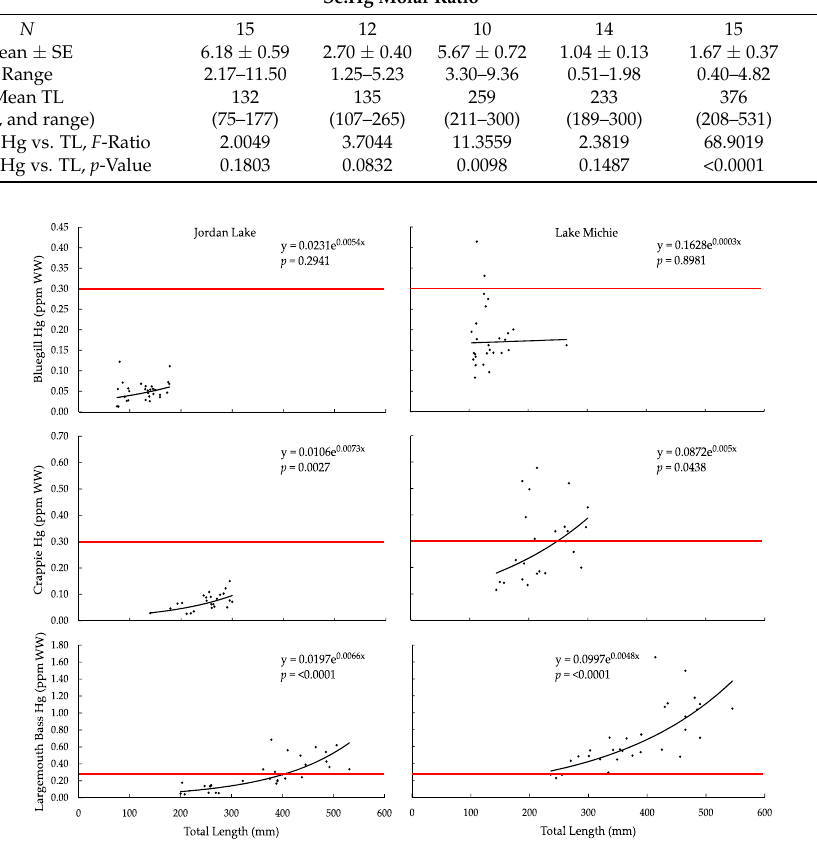
Figure 2. Tissue Hg concentration (ppm WW) vs. total length (mm) in ( a ) bluegill from Jordan Lake, ( b ) bluegill from Lake Michie, ( c ) crappie from Jordan Lake, ( d ) crappie from Lake Michie, ( e ) largemouth bass from Jordan Lake, and ( f ) largemouth bass from Lake Michie. The red horizontal line indicates the U.S. Environmental Protection Agency 0.3-ppm Fish Tissue Residue Criterion. 3.2. Selenium For all species in Jordan Lake, Se concentrations increased with total length; in Lake Michie, the concentrations decreased with length (Figure 3). The relationship was significant for bluegill and largemouth bass in Jordan Lake, and for bluegill and crappie in Lake Michie ( p < 0.05; Table 3). Mean Se concentrations and ranges for all species in Jordan Lake were similar, despite the differences in lengths, while the mean concentration decreased and the range narrowed from bluegill to crappie to